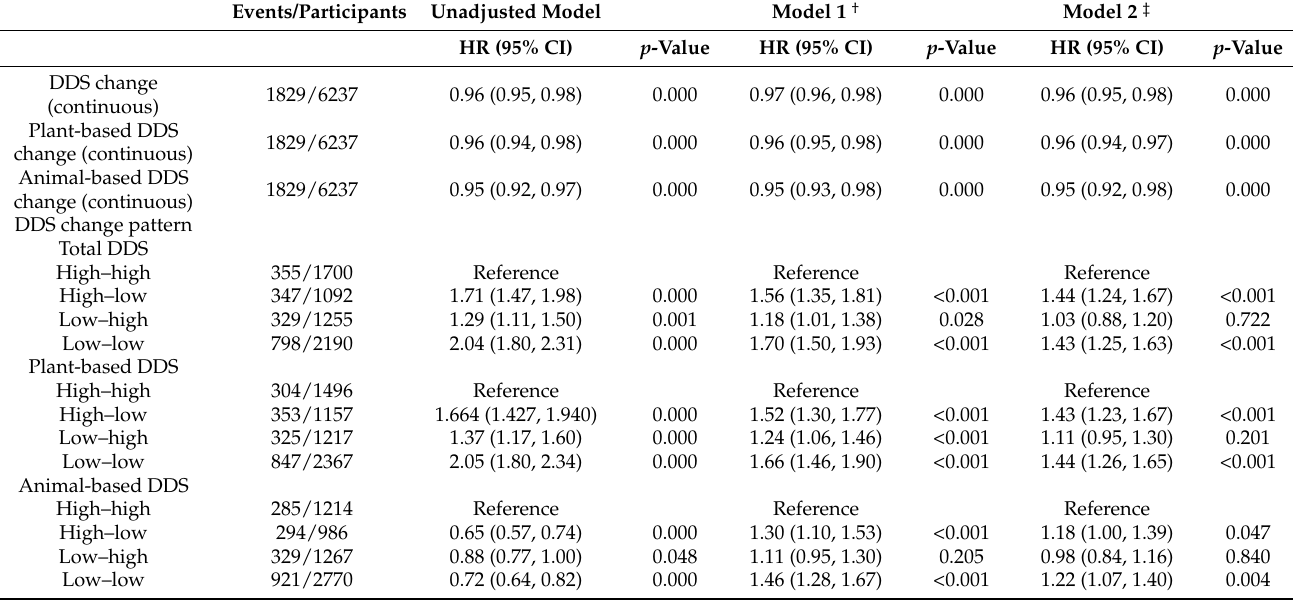
Table 2. The association between DDS change patterns and incident cognitive impairment.